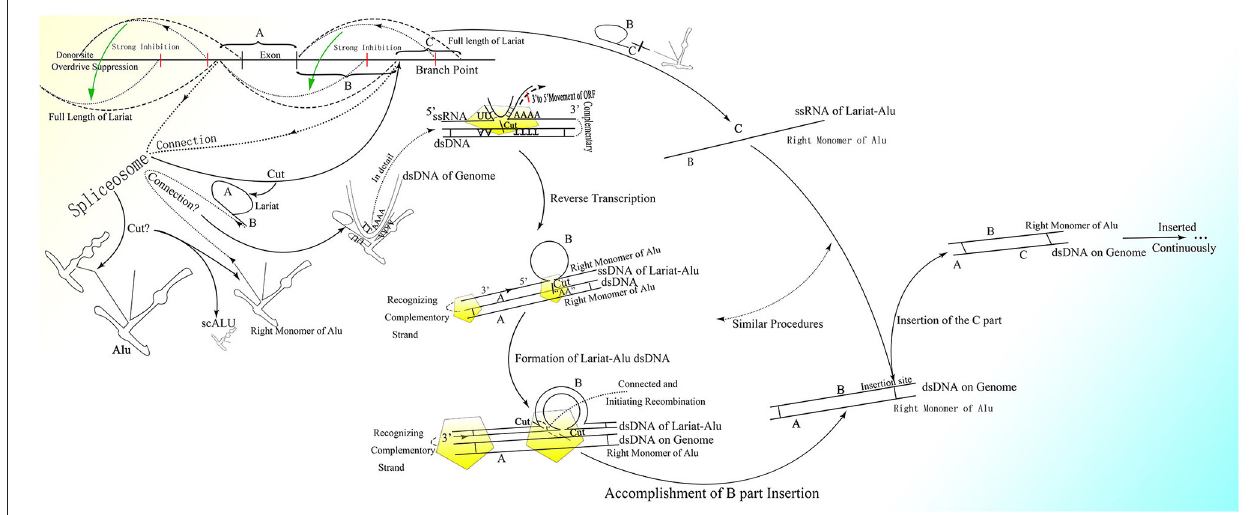
FIGURE 3 | The detailed process of the CNV extension mechanism. Partially overlapping lariats would be produced during pre-mRNA processing with exons excised of high probability by overdrive suppression. With the pre-mRNA spliced and connected, the right monomer of the Alu element could be spliced and connected to the lariats produced at the same time. With the help of ORF2p on the right monomer of the Alu element, the lariat-Alu ssRNA could be converted into dsDNA at the specific insertion site, with part A on the left and the right monomer of Alu on the right. Then part B would be inserted into the genome facilitated by HR with the two nicks produced by ORF2p. Part C would be inserted further by lariats containing parts B and C at the specific insertion site between part B and the right monomer of the Alu element. CNVs would be extended continuously and spontaneously through this